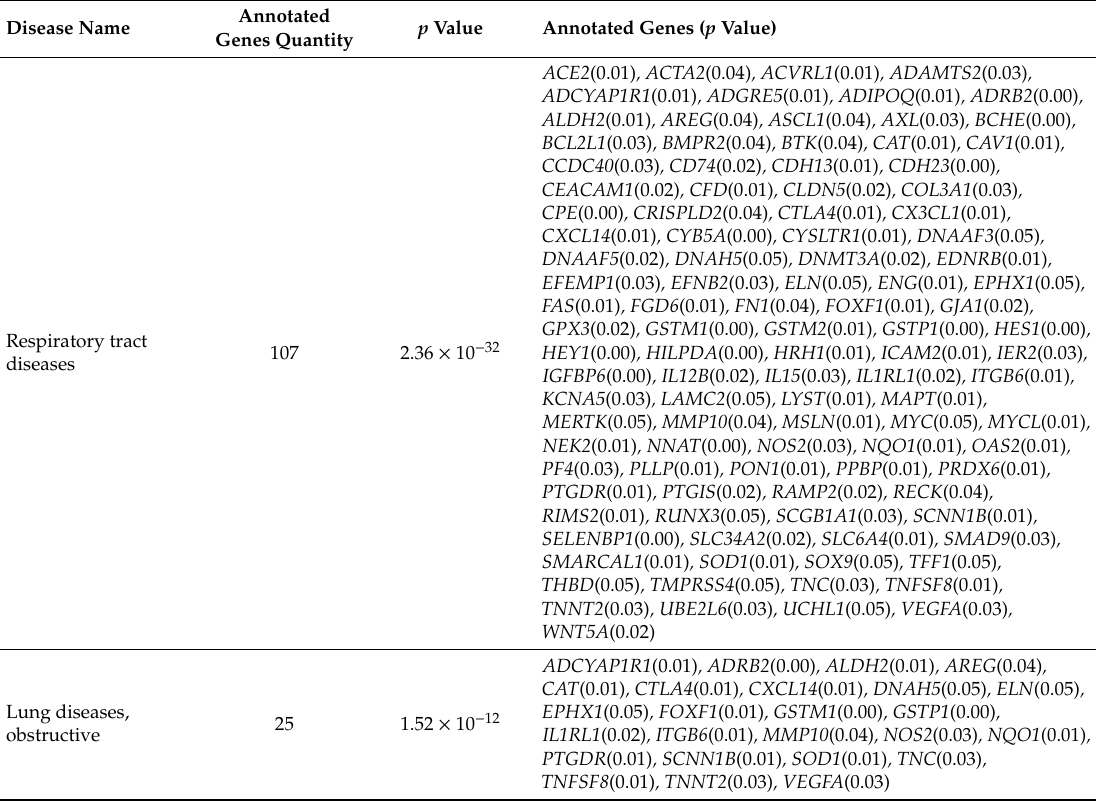
Table 2. Comparative Toxicogenomics Database (CTD) disease category analysis of genes altered by Kathon